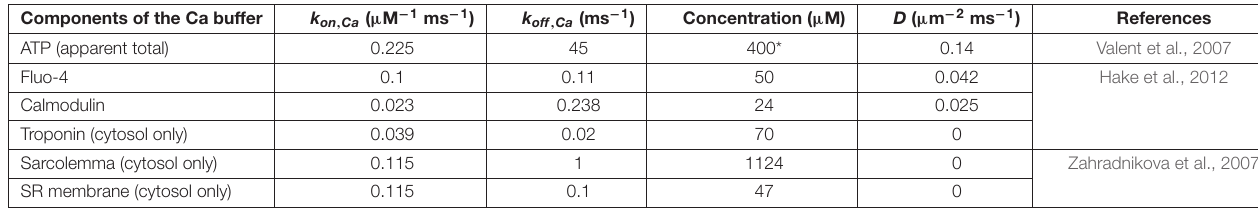
TABLE 2 | Calcium buffers used for calculation of Ca 2 + concentrations and diffusion. Components of the Ca